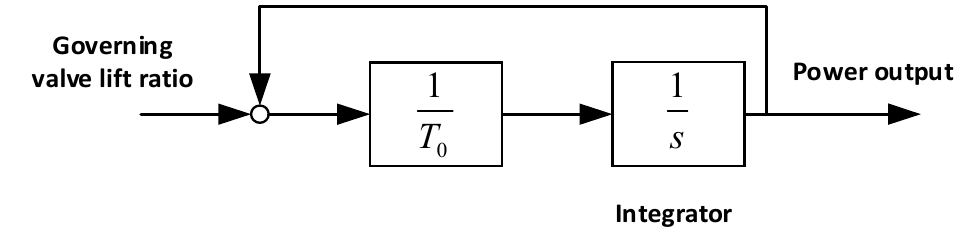
Figure 4. Nozzle Volume Model.